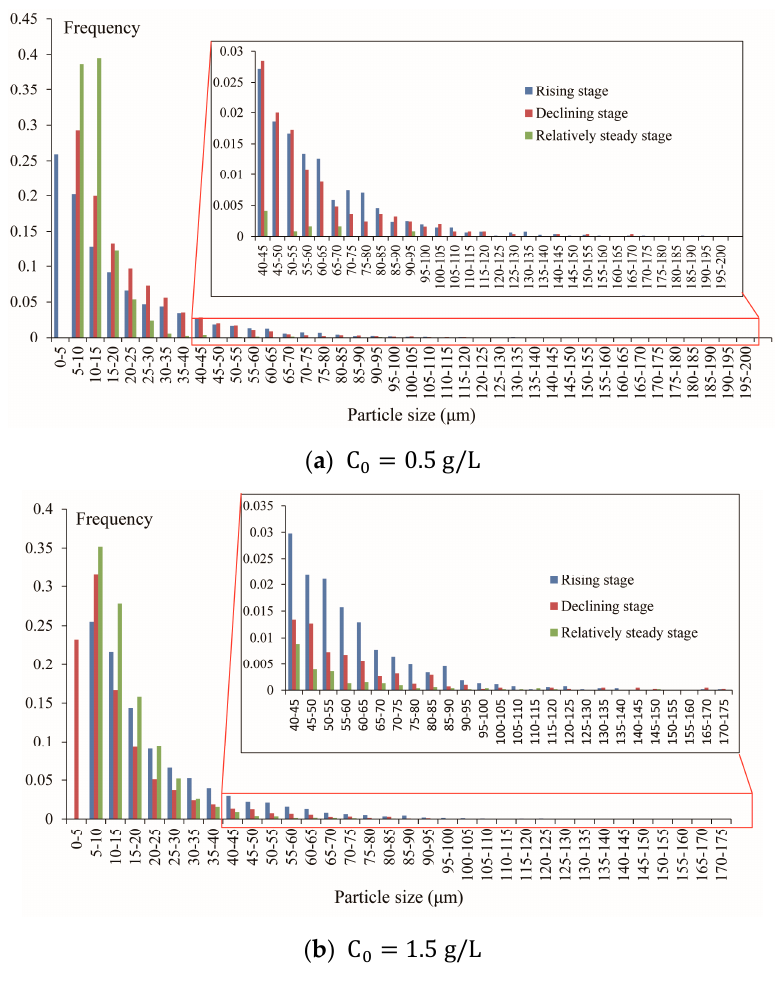
Figure 6. Breakthrough curves of iron in succession tests of different injected concentrations. PV represents pore volume, (cid:1829) (cid:3007)(cid:3032) represent iron concentration in the effluents. Solid points and lines in red, green, blue, purple, and black represent C (cid:2868) = 2.5, 2.0, 1.5, 1.0, and 0.5 g/L,